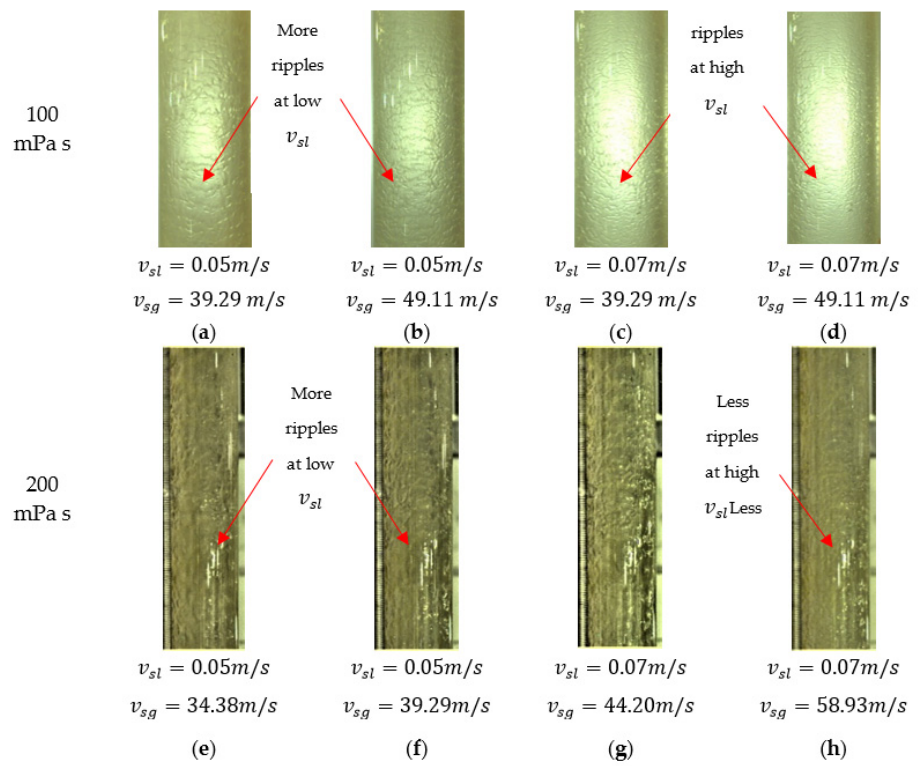
Figure 4. Flow patterns observed at different v sg values for v sl values of 0.05 and 0.07 m/s for liquid viscosities of ( a – d ) 100 and ( e – h ) 200 mPa s respectively (Adopted from Ribeiro et al., [33] with permission from Taylor and Francis).